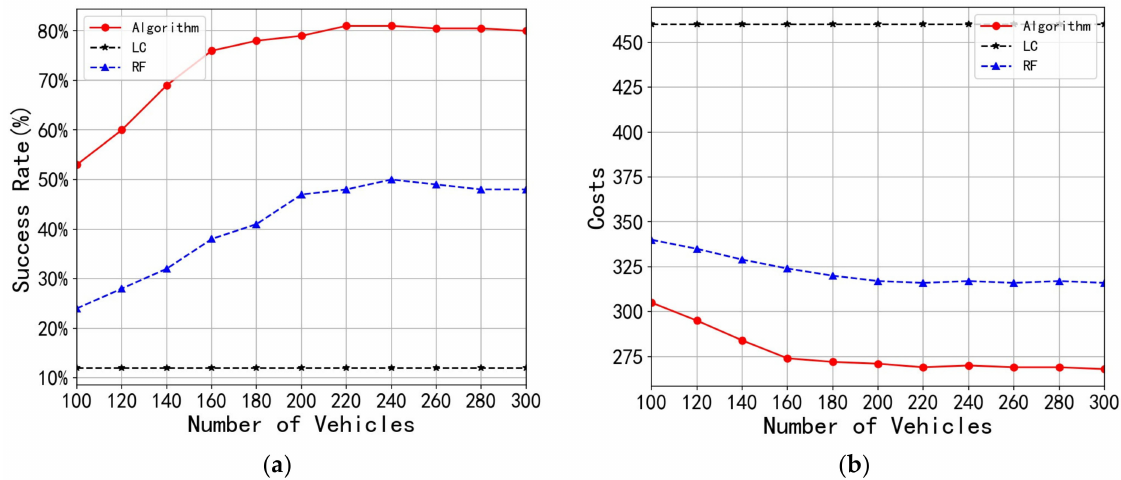
Figure 7. Simulation results with diverse deployed resources. ( a ) Task successful rate under resources, and ( b ) execution cost under resources.